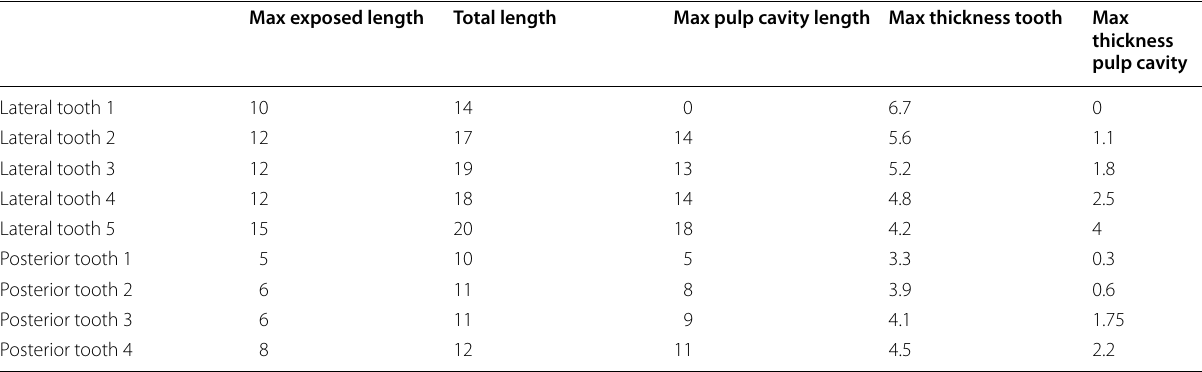
Table 1 Measurements made of the teeth of Leptodontichthys ziregensis gen. et sp. nov. of the lateral and posterior tooth rows are given from the most ventral (Posterior/Lateral tooth 1) to the most dorsal tooth (Posterior tooth 4 and